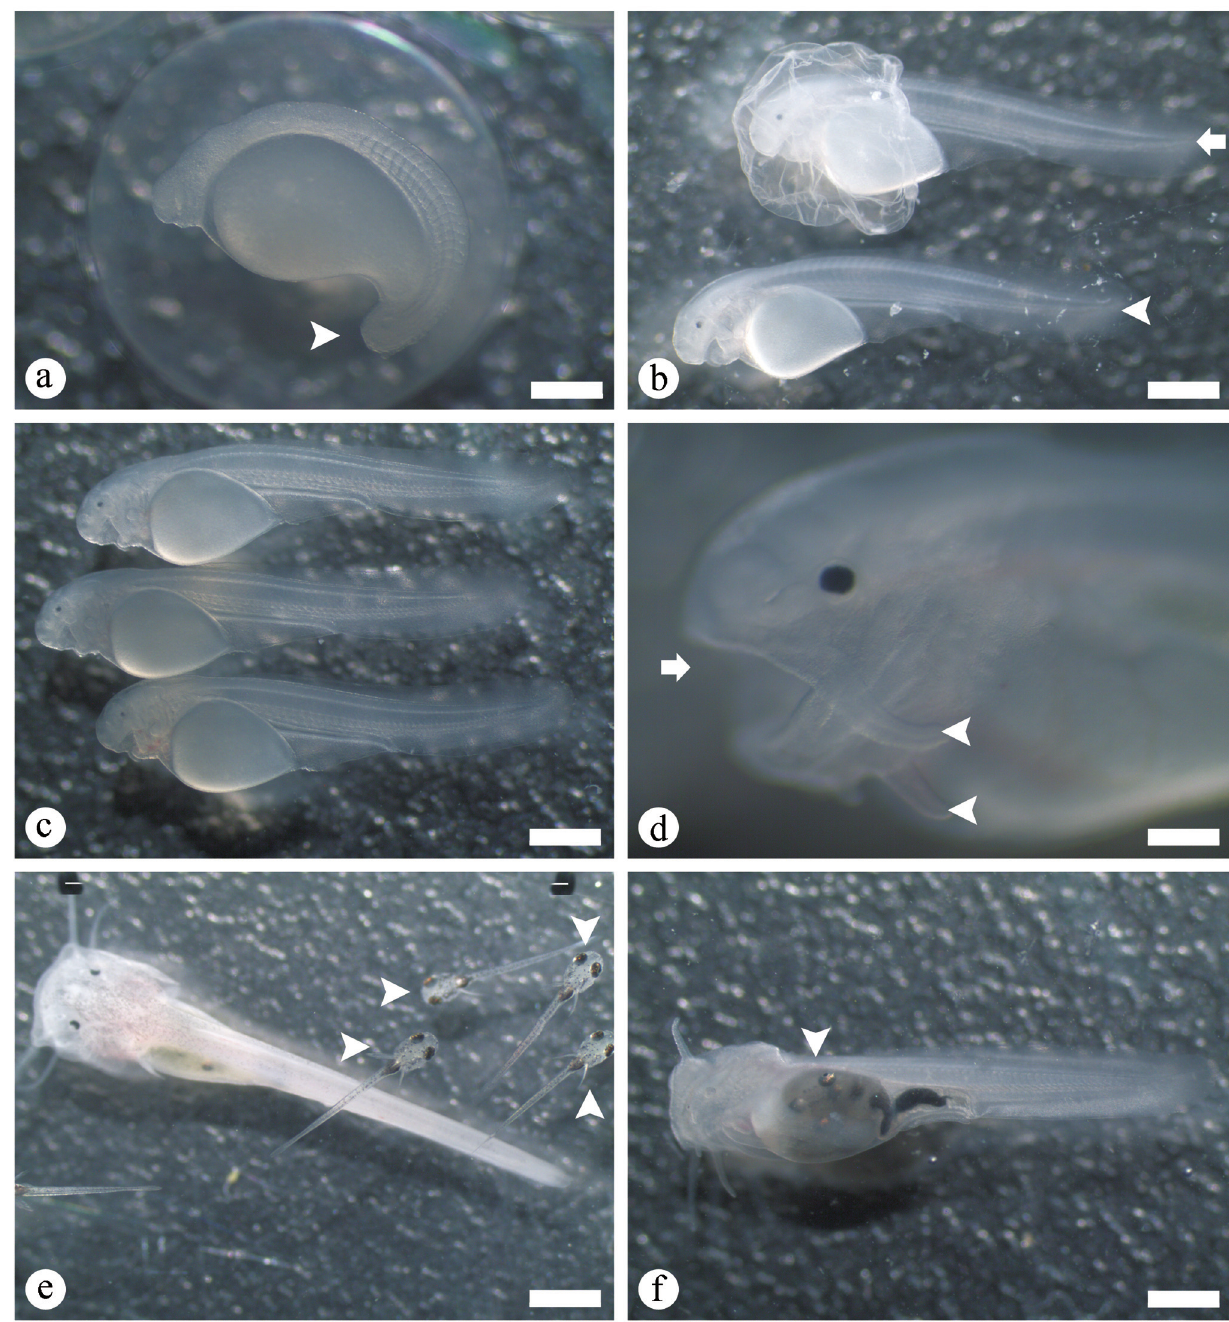
Fig. 4. Macroscopic aspects of larval development of Steindachneridion parahybae . a ) complete development and the tail release (arrowhead) (25 h AF); b ) hatching (time zero AH) - 4.30 ± 0.70 mm (54 h). Hatched (arrowhead), and hatching (tearing of the chorion, and fry release; arrow); c ) after hatching, the larvae were still translucent with a non-pigmented body; d ) early formation of barbells (arrowhead) (38 h 30 min AH), and larvae with opened mouth (arrow) were observed although exogenous feeding have not been observed yet (50 h AH); e ) larvae fully developed (all structures) with barbells (60 h AH), and exogenous feeding of S. parahybae with A. altiparanae larvae (arrowhead) (100 h 57 min AH); f ) Detail of S. parahybae feeding at A. altiparanae larvae (arrowhead). Bars: (a) 0.3 mm; (b-c) 0.9 mm; (d) 0.2 mm (e-f) 0.8